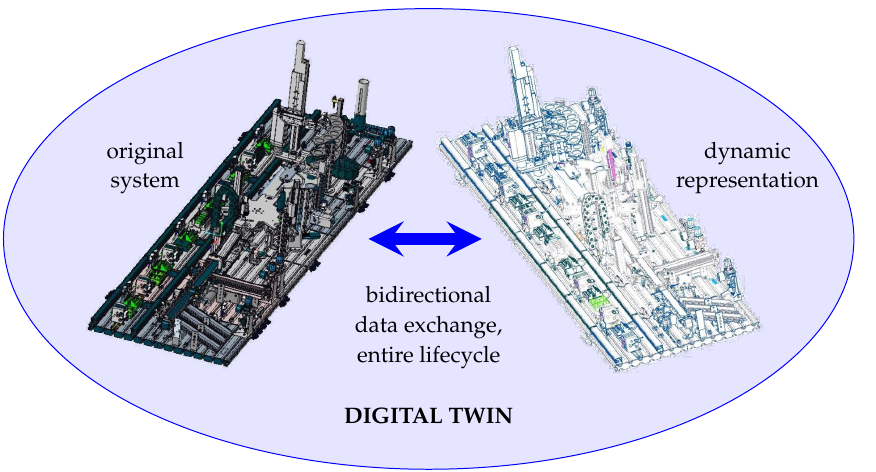
Figure 1. Characteristics of Digital Twins.